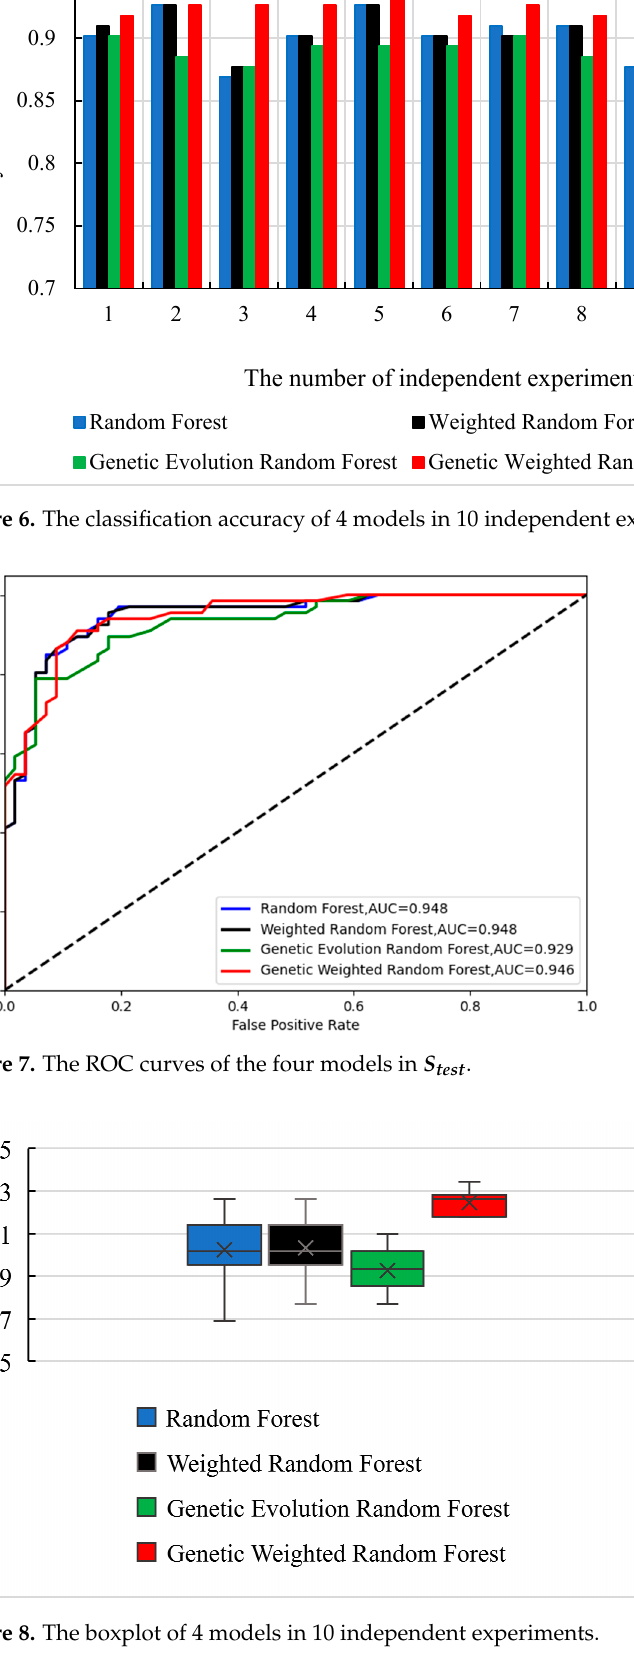
Figure 8. The boxplot of 4 models in 10 independent experiments.